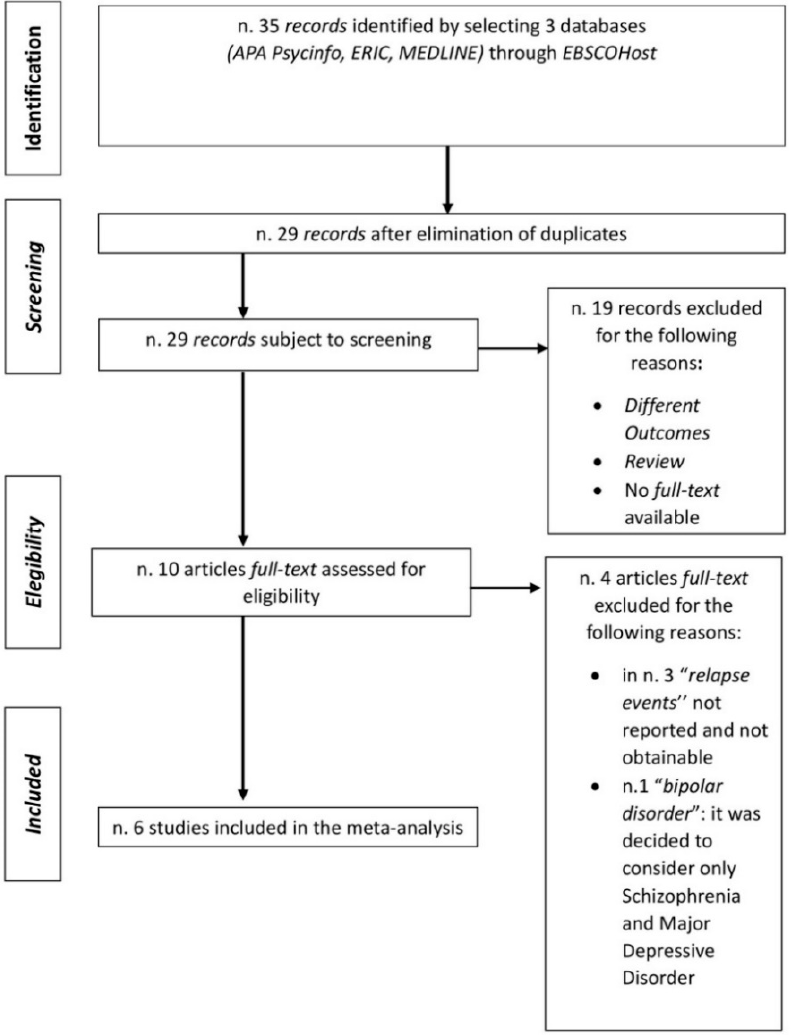
Figure 1. Search strategy flowchart.